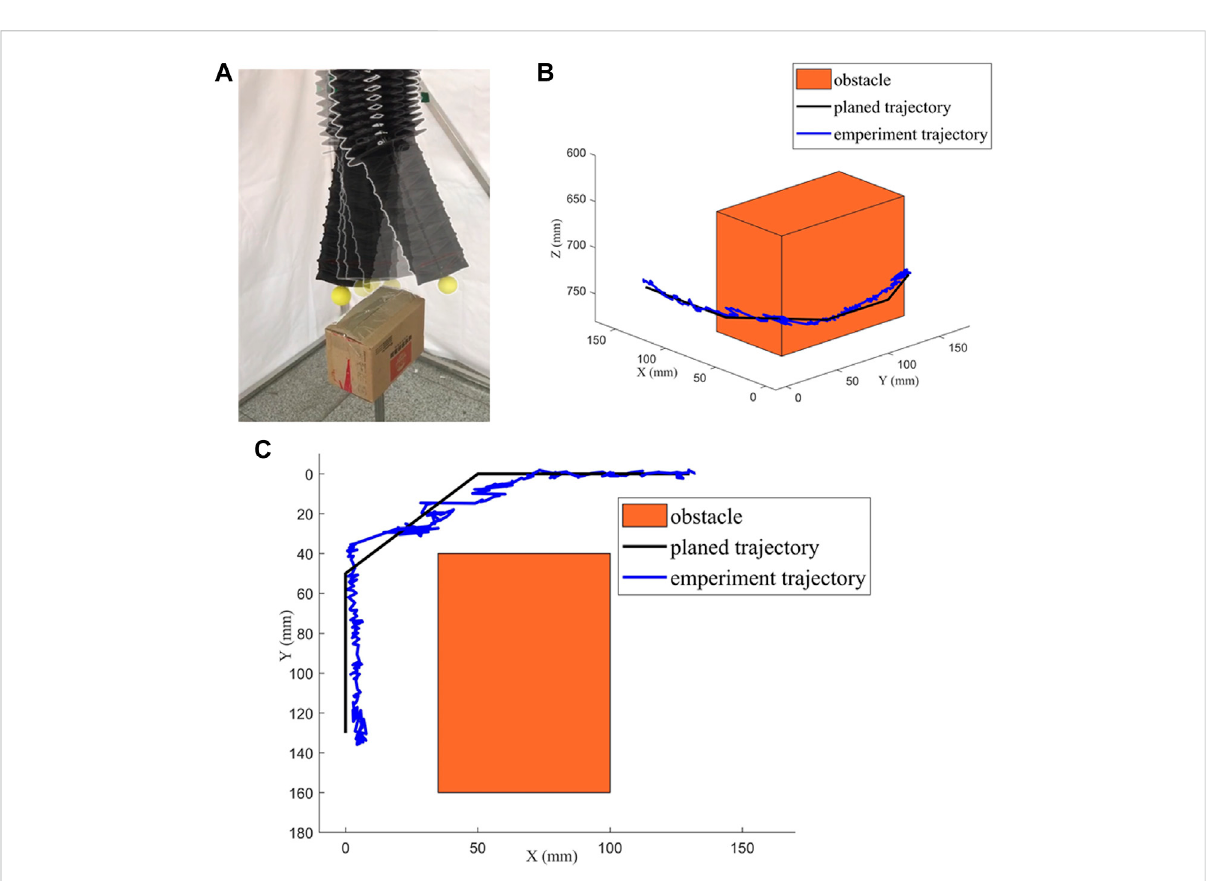
FIGURE 11 Experimental results of path planning. (A) obstacle avoidance path planning experiment. (B) comparison between the simulation path and the test record. (C) Top view of (B).